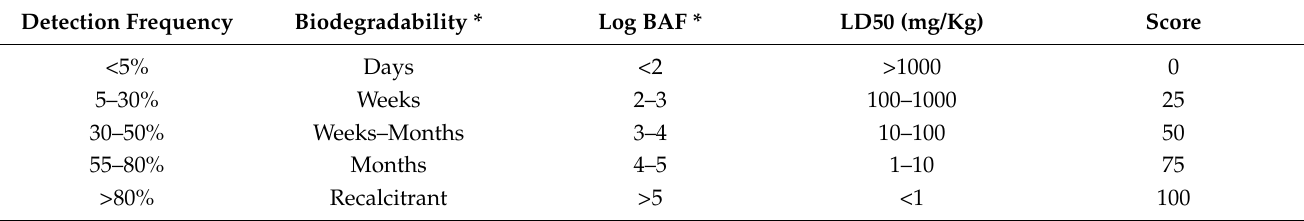
Table 3. Scoring system for prioritisation of the tentatively identified